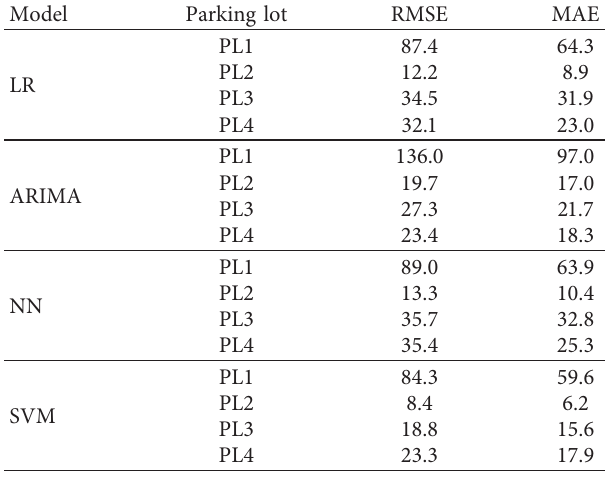
Table 2: Forecasting results of the four parks with